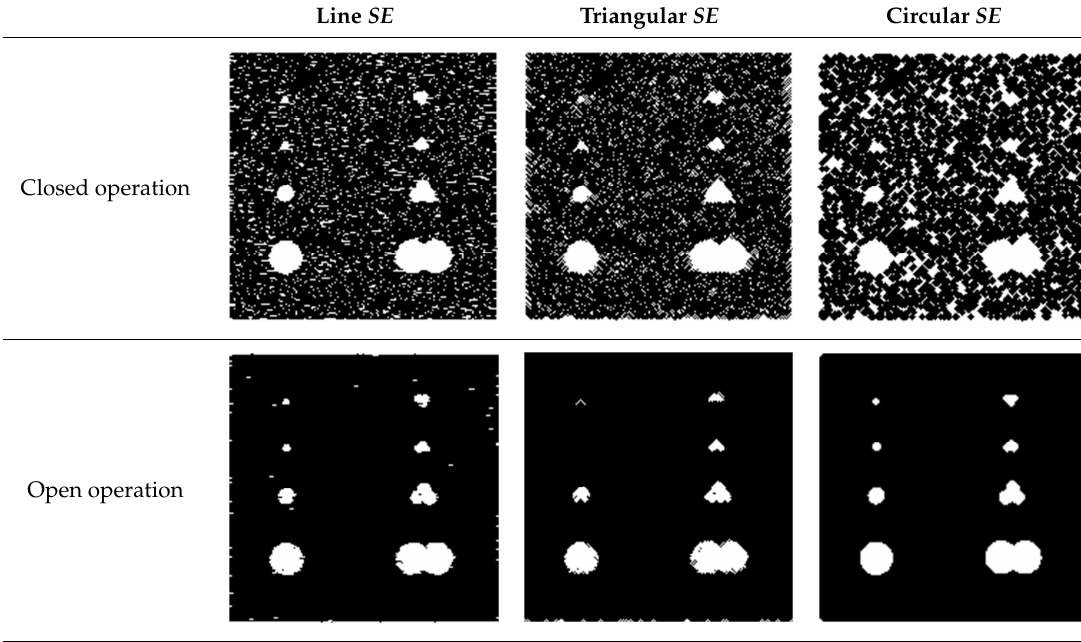
Figure 7. Ultrasonic testing simulation images. ( a ) original image; ( b ) noised image. Table 2. Result of the combination of different structure element ( SE ) and different operations. Line SE